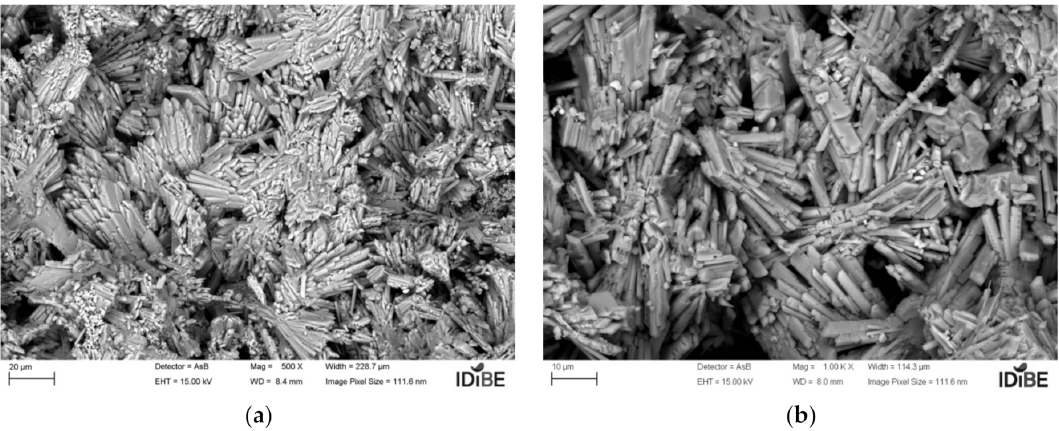
Figure 12. Micrograph of the 0.2% polycarboxylate compound (lot VS1): ( a ) 20 µ m; ( b ) 10 µ m (source: the